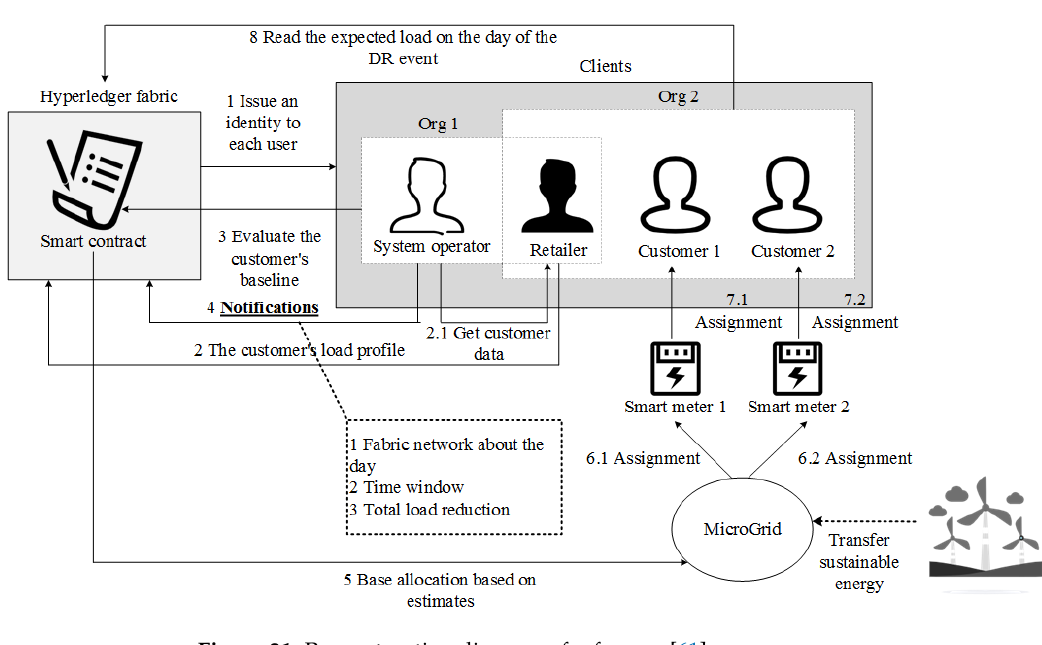
Figure 31. Reconstruction diagram of reference [61].